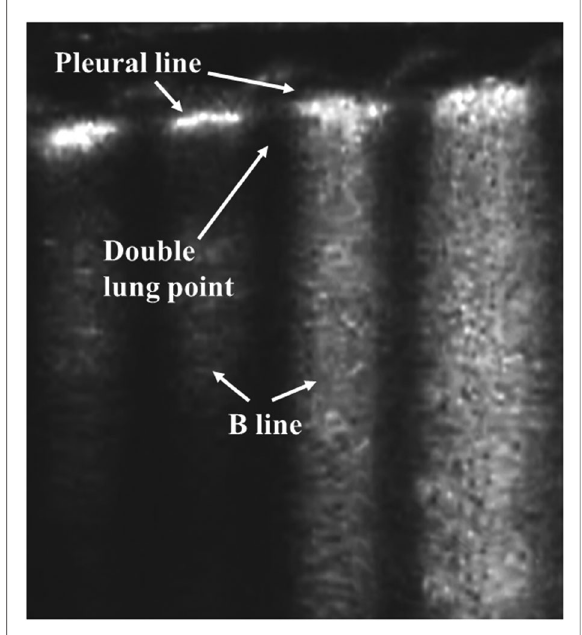
FIGURE 4 Transient tachypnea of the newborn on lung ultrasonography. Double lung point: there is a sharp change in echogenicity as a result of the abundance of B-lines between the upper and the lower lung fi